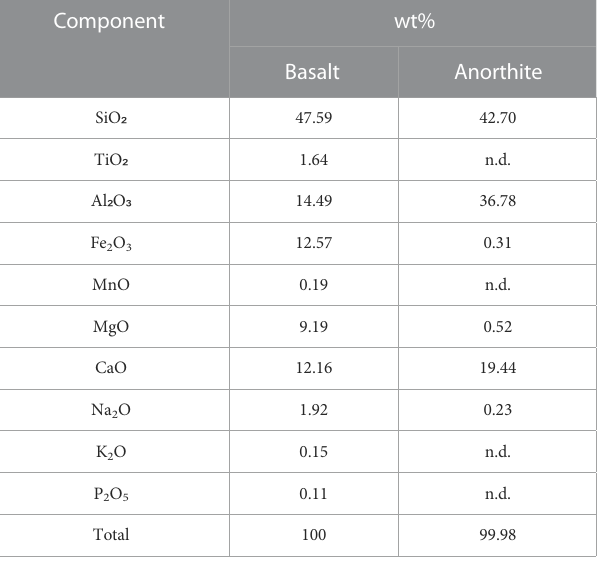
TABLE1Chemicalcompositionsofbasalt andanorthite determinedusingXRF.